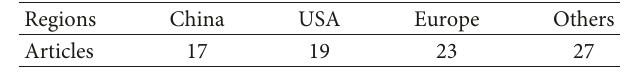
Table 1: Source of data